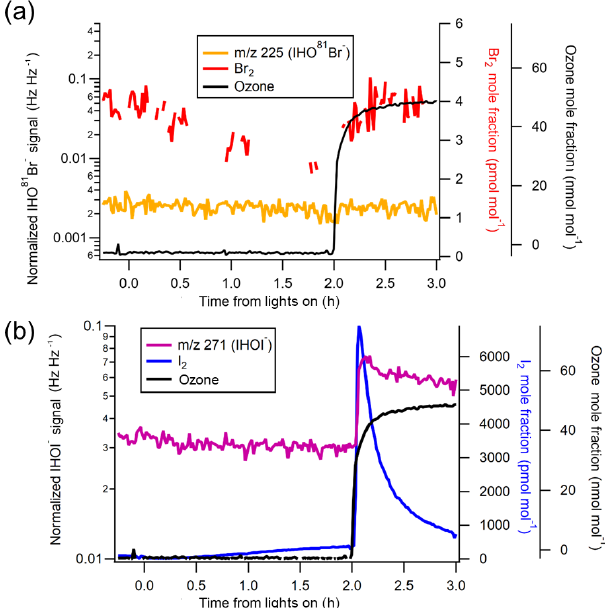
Figure 3. Normalized, background-subtracted HOX signals from Experiment IO2, pH = 4.7. (a) Comparison of Br 2 mole fractions to HOBr ( m/z 225). Note that the HOBr signal should be consid- ered only qualitatively as its identity could not be confirmed using isotopic ratios with m/z 223 due to its relatively large background signal. (b) Effect of O 3 on I 2 and